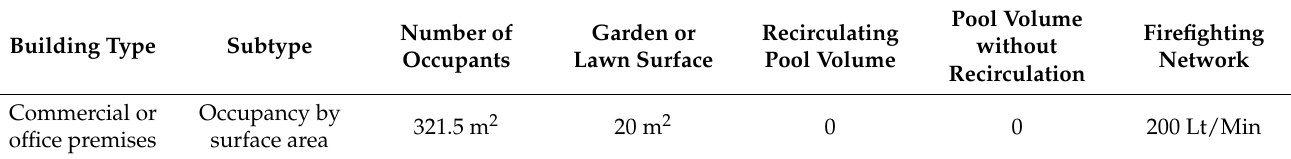
Figure 9. Sanitary plumbing network layout for retail stores and offices. Table 11. Global data for the retail store building case study.